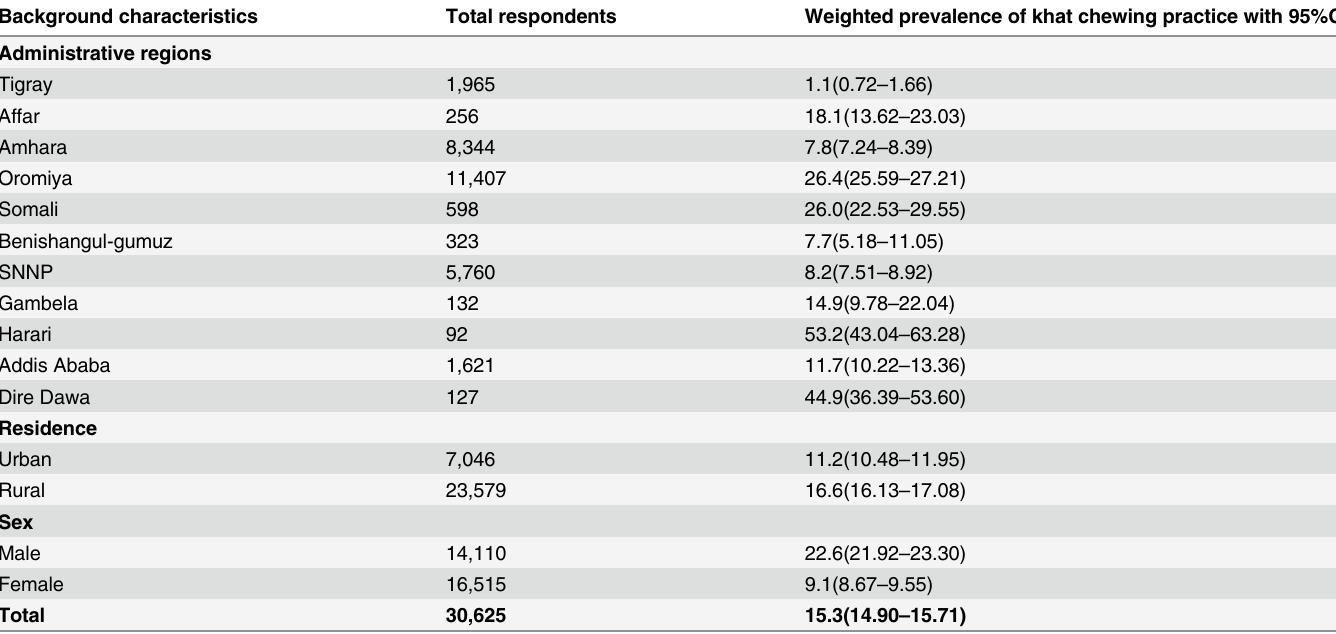
Table 1. Prevalence of khat chewing practice among adults across administrative region, residence and gender in Ethiopia, 2011. Background characteristics